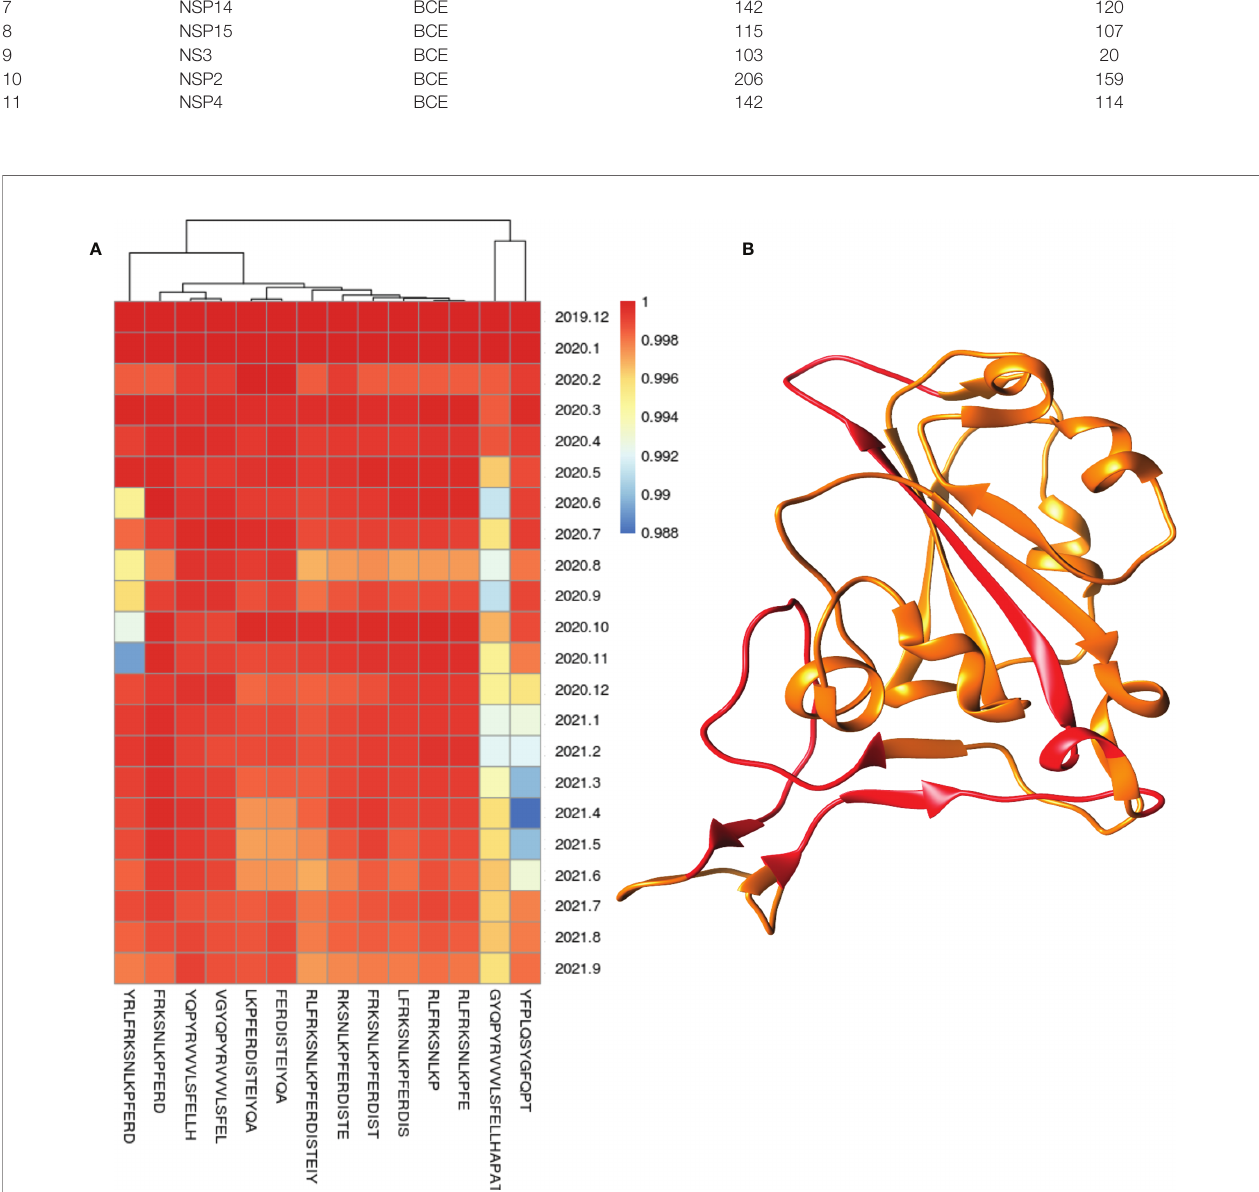
FIGURE 1 | Heatmap of conservation of highly conserved (>99% strains) epitopes from the region which interact with host receptor (A) and location of these highly conserved epitopes (shown in red color) in the spike protein receptor-binding domain (B)